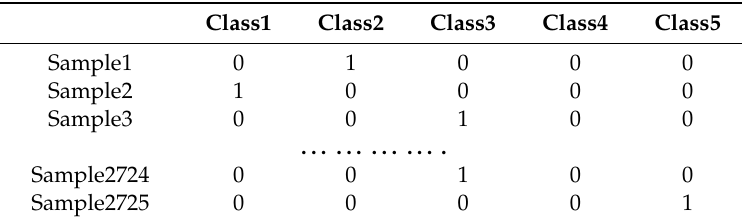
Table 4. The schematic diagram of one-hot